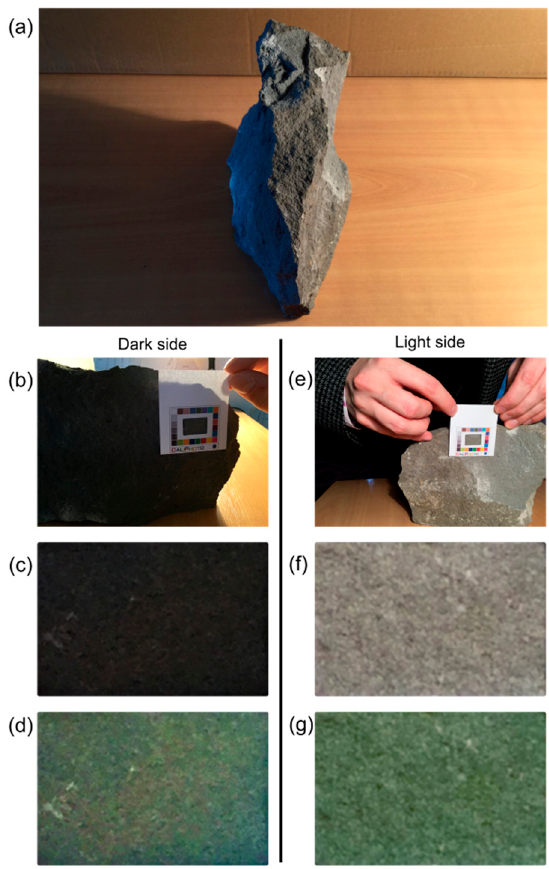
Figure 4. Using the CaliPhoto method to compare two sides of a sample. ( a ) Photograph of a rock sample (trachybasalt) illuminated by the sun on the left, ( b – d ), and by a filament bulb on the right, ( e – g ). ( b ) and ( e ), images of the left and right sides of the sample with the CaliPhoto colour plate. ( c ) and ( f ), images of only the area in the centre of the colour plate. The average RGB values of these areas are respectively R,G,B = 43,54,72 and R,G,B = 151,137,126 before correction ( Δ 12 = 33%). ( d ) and ( g ), the same images after correction using the CaliPhoto method. The two sides of the rock are shown to be quite similar in colour, with average CaliPhoto R,G,B values equal to 93,107,84 and 90,109,81 respectively ( Δ 12 = 1% between the two images), suggesting that they have similar compositions. N.B. the CaliPhoto colour of the materials may differ from their colour as seen by human eyes.